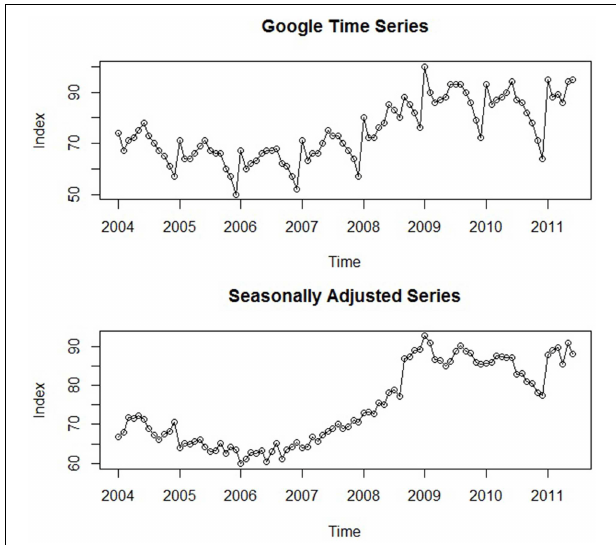
FIGURE 1 | A plot of the original Google job search time series and the series after seasonal